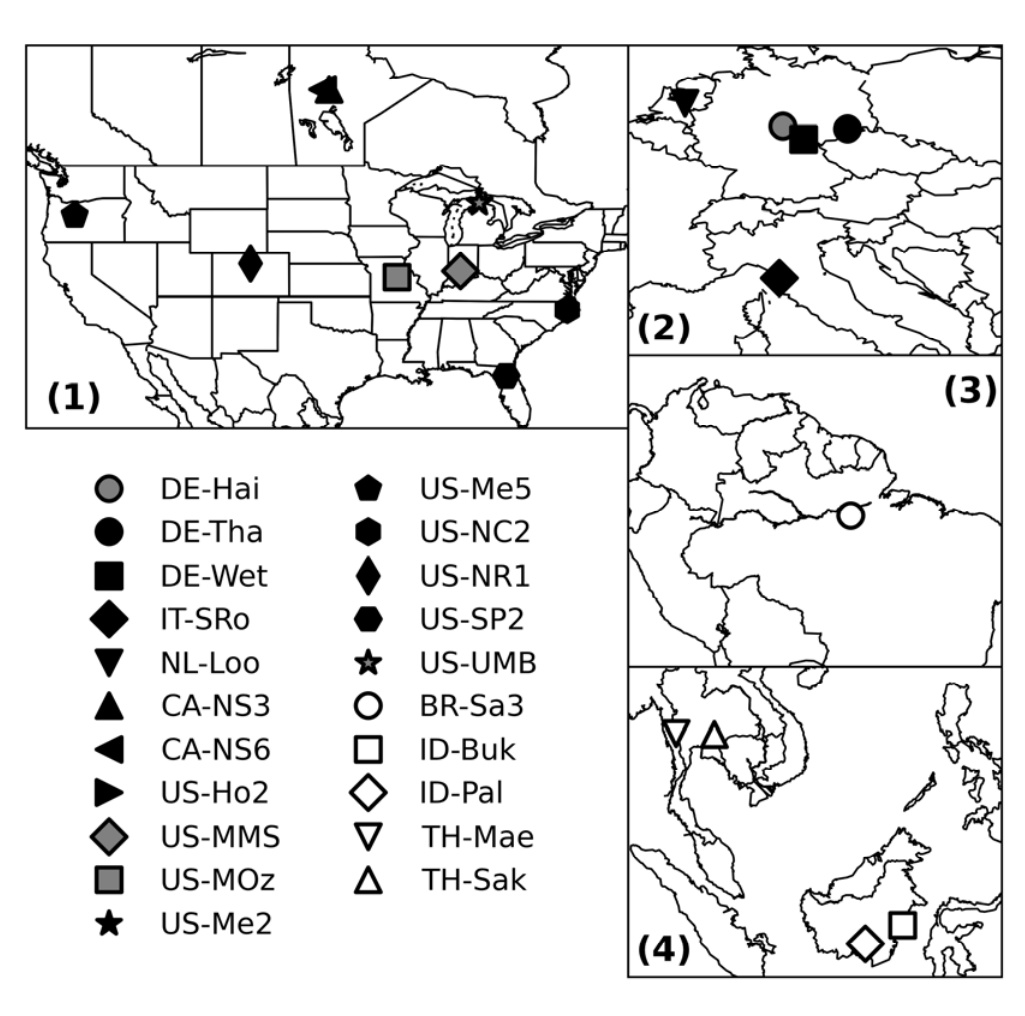
Figure 1. Map of the flux tower sites used in this study. The data are from AmeriFlux in North America ( 1 ), CarboEurope in Europe ( 2 ), AmeriFlux in Brazil ( 3 ) and AsiaFlux in the Southeast Asia ( 4 ). Temperate deciduous forests are marked with gray symbols. Tropical forests are marked with white